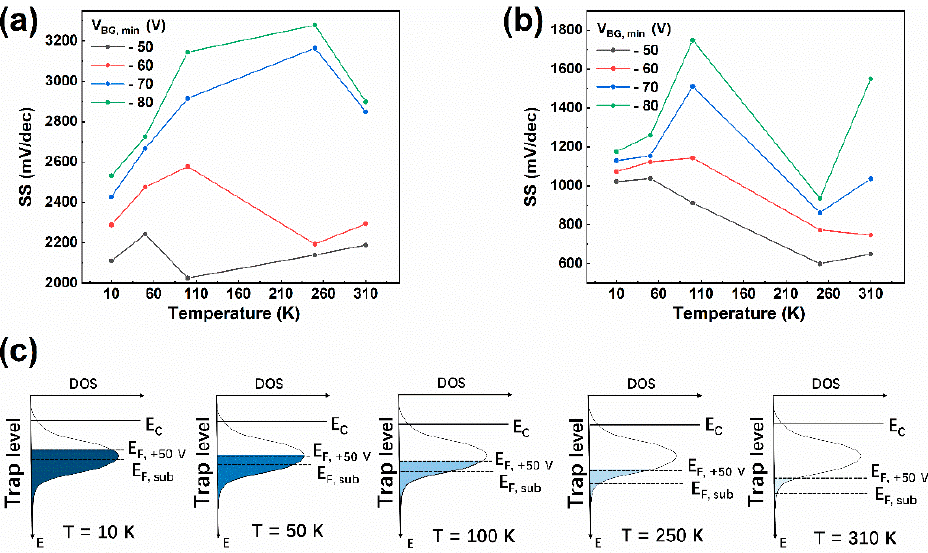
Figure 3. Transfer curves at a series of temperatures (10–310 K) for forward sweep ( a ) and backward sweep ( b ), respectively. Relationship between V TH , V BG, min , and temperature for forward sweep ( c ) and backward sweep ( d ), respectively.